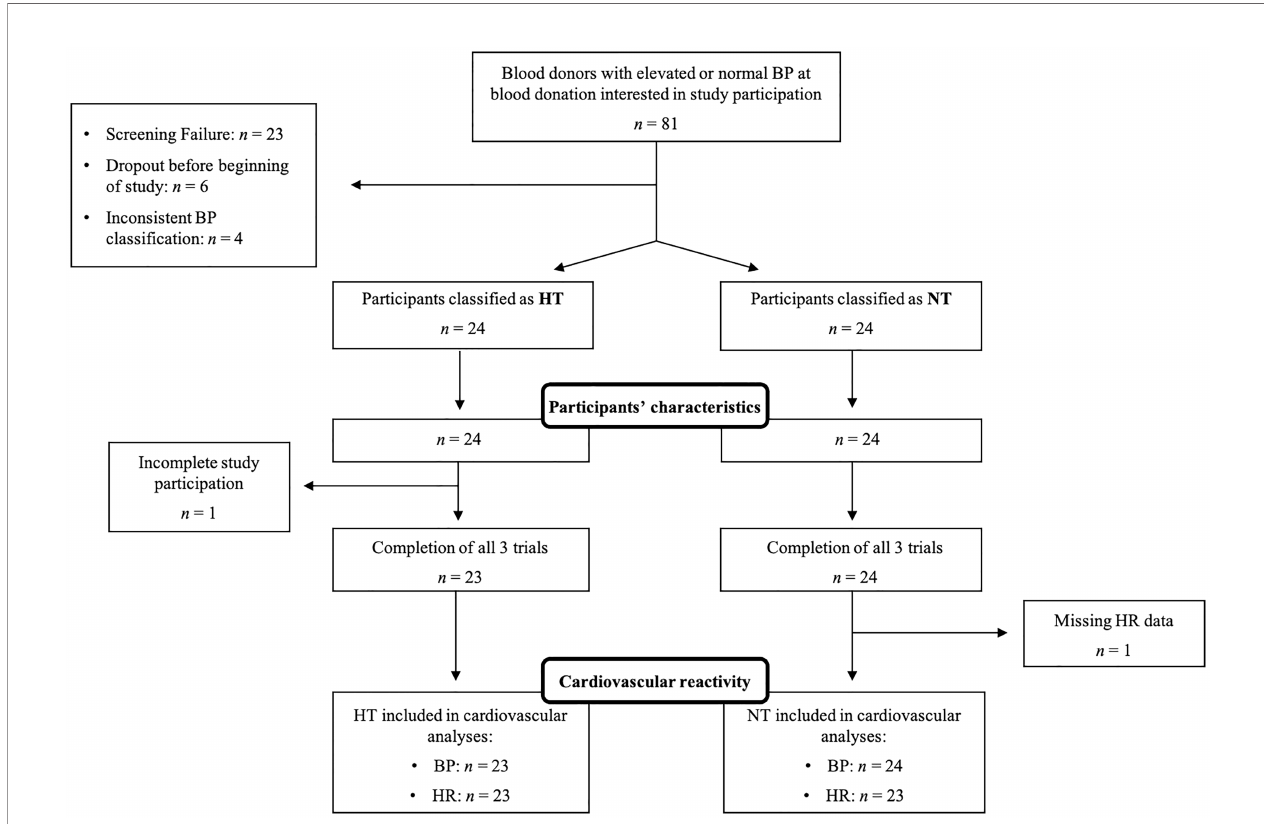
FIGURE 1 | Participant fl ow chart. BP, blood pressure; HT, hypertensive participants; HR, heart rate; n , sample size; NT, normotensive